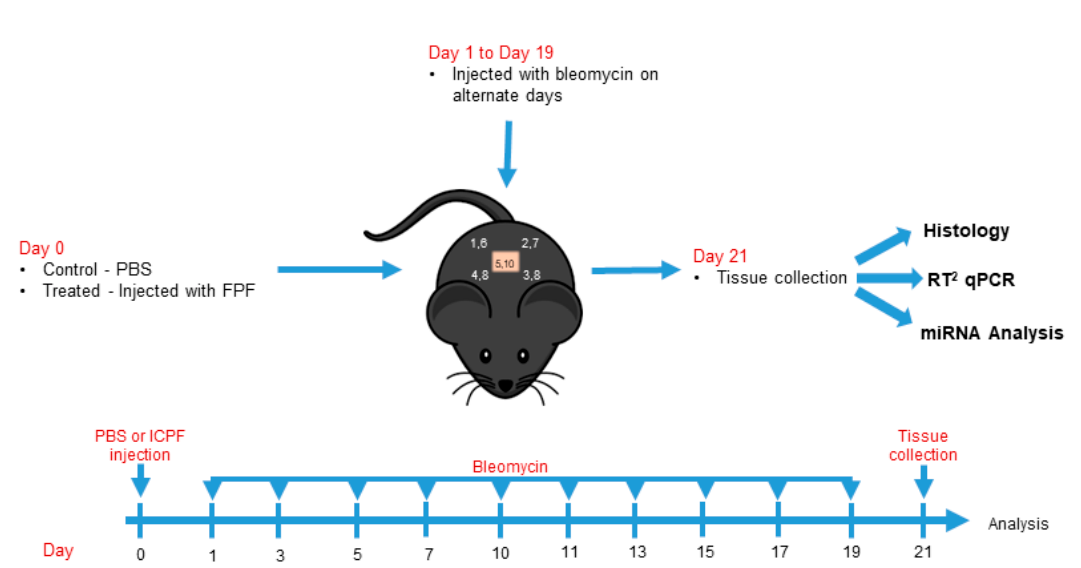
Figure 2. Schematic representation of the bleomycin treatment protocol. Animals received bleomycin injections on alternate days. Each animal received a total of 10 subdermal injections of bleomycin. Tissues collected at Day 21 were processed for histology, or flash frozen for RT 2 qPCR and miRNA analysis. N = 5 mice/group.